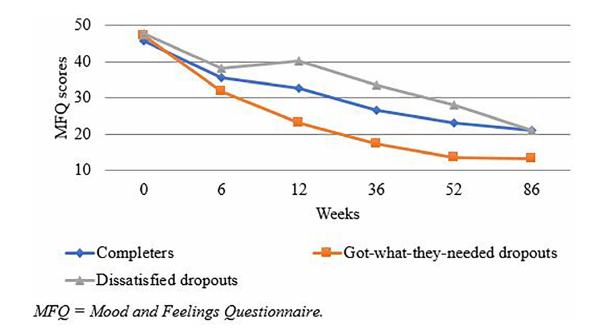
FIGURE 2 | Mean MFQ scores at each time point, for ‘got-what-they-needed’ dropouts, ‘dissatisfied’ dropouts and